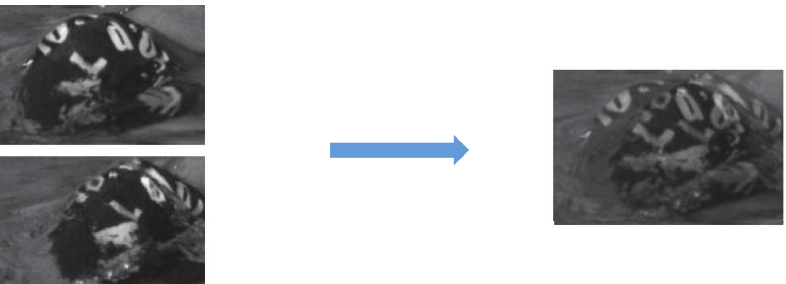
Figure 13: Principle of the composite filter. Left: reference images. Right: composite image which consists of a weighted summation of the two reference images.